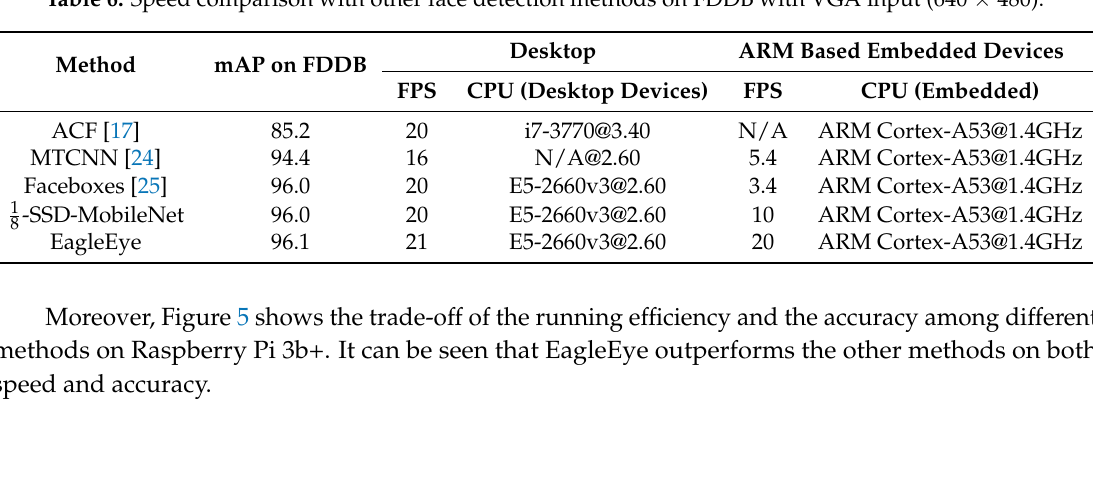
Table 6. Speed comparison with other face detection methods on FDDB with VGA input (640 ×